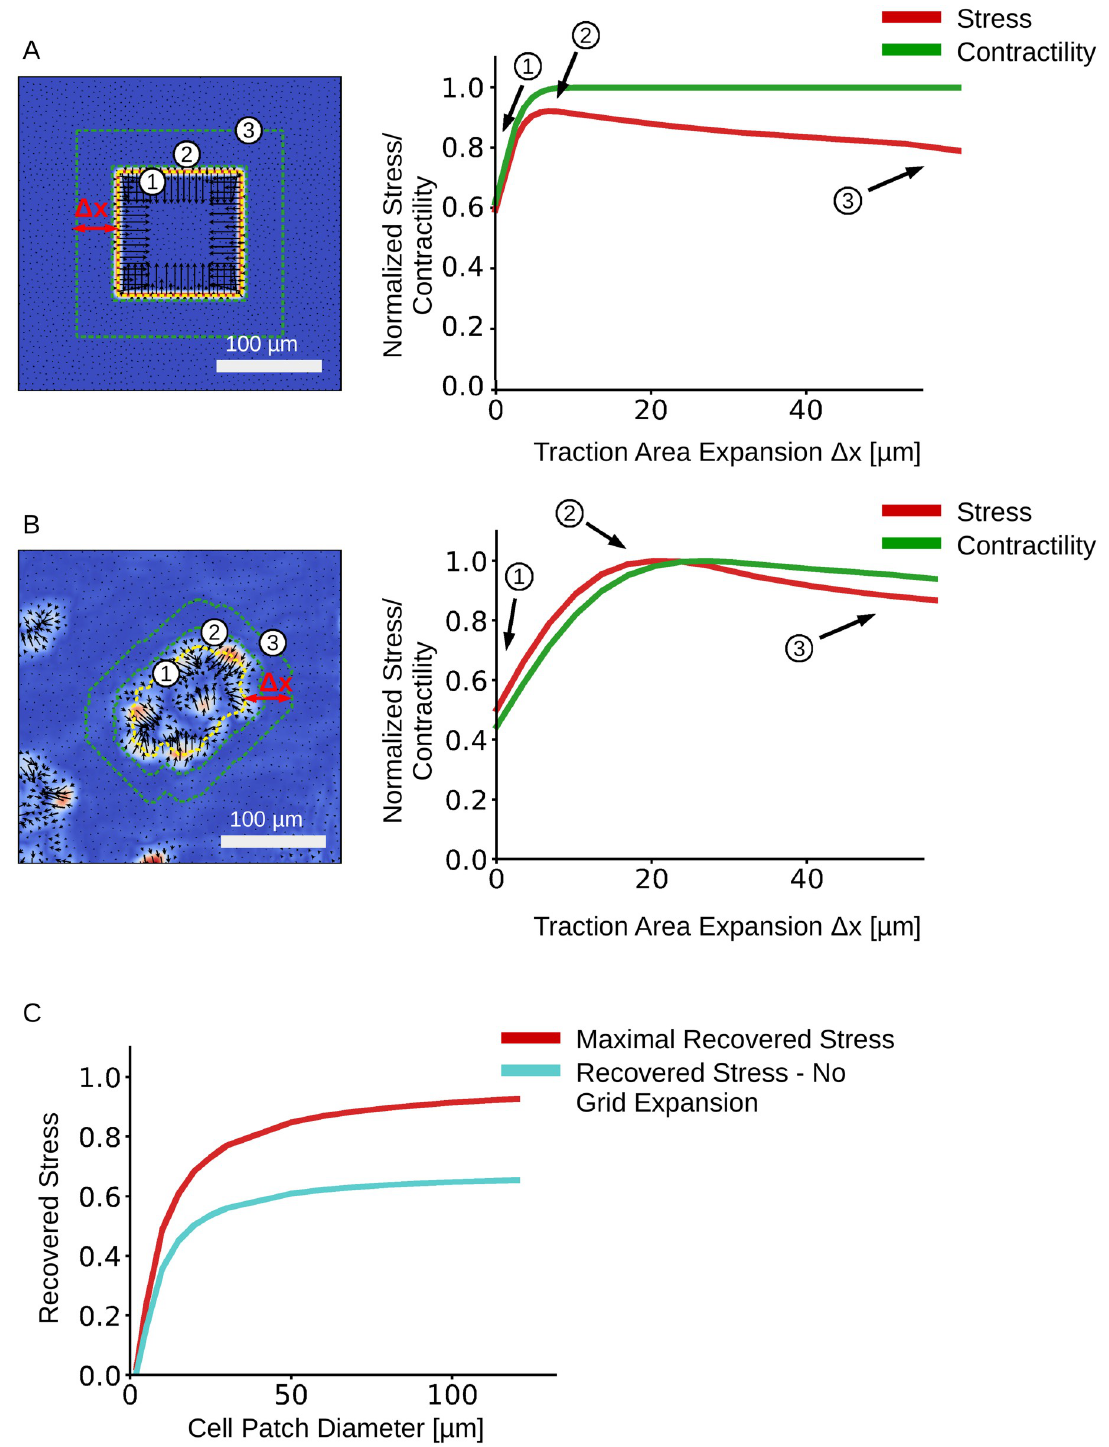
Fig 4. Effect of increasing the traction area on stress and contractility recovery. The predicted traction fields of a synthetic test system (A) and an MDCK cell patch (B). The outlines of 3 representative FEM-grids are shown on the left. The relationship between average normal stress and FEM-grid area is shown on the right. C: Influence of the cell patch size of a synthetic data set on the maximally recovered mean normal stress with FEM-grid expansion (red), and the recovered mean normal stress without FEM-grid expansion